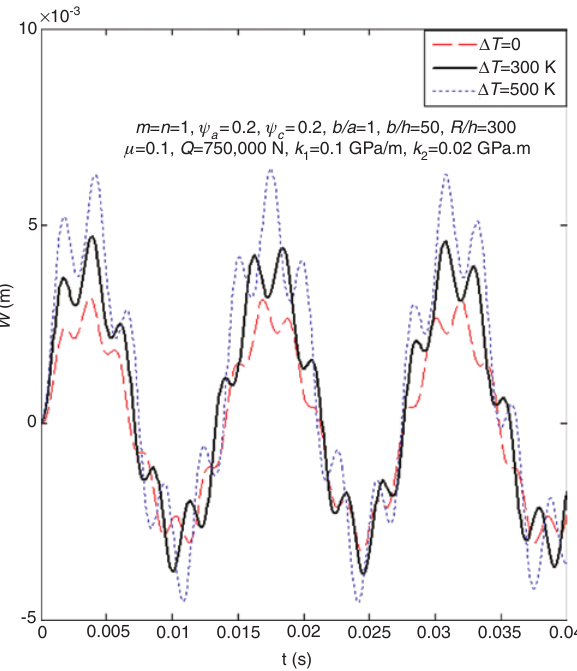
Figure 10: Effects of the temperature increment on the non-linear dynamic response of the polymer composite cylindrical panel.